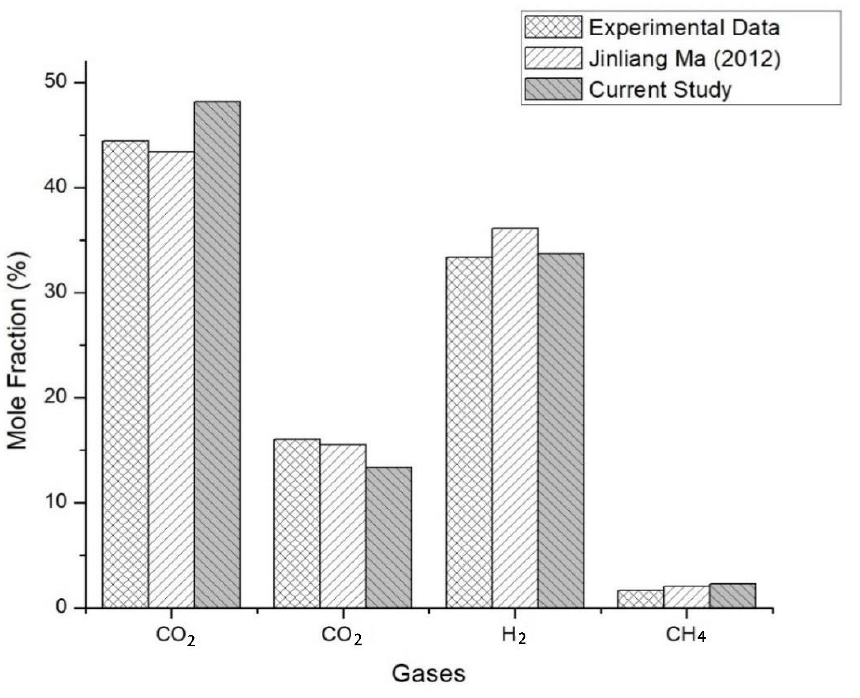
Figure 6. Comparison of product gas mole fractions (% dry basis) from experimental data Foster (1994) [3], Ma et al. (2012) [8], and the current study.